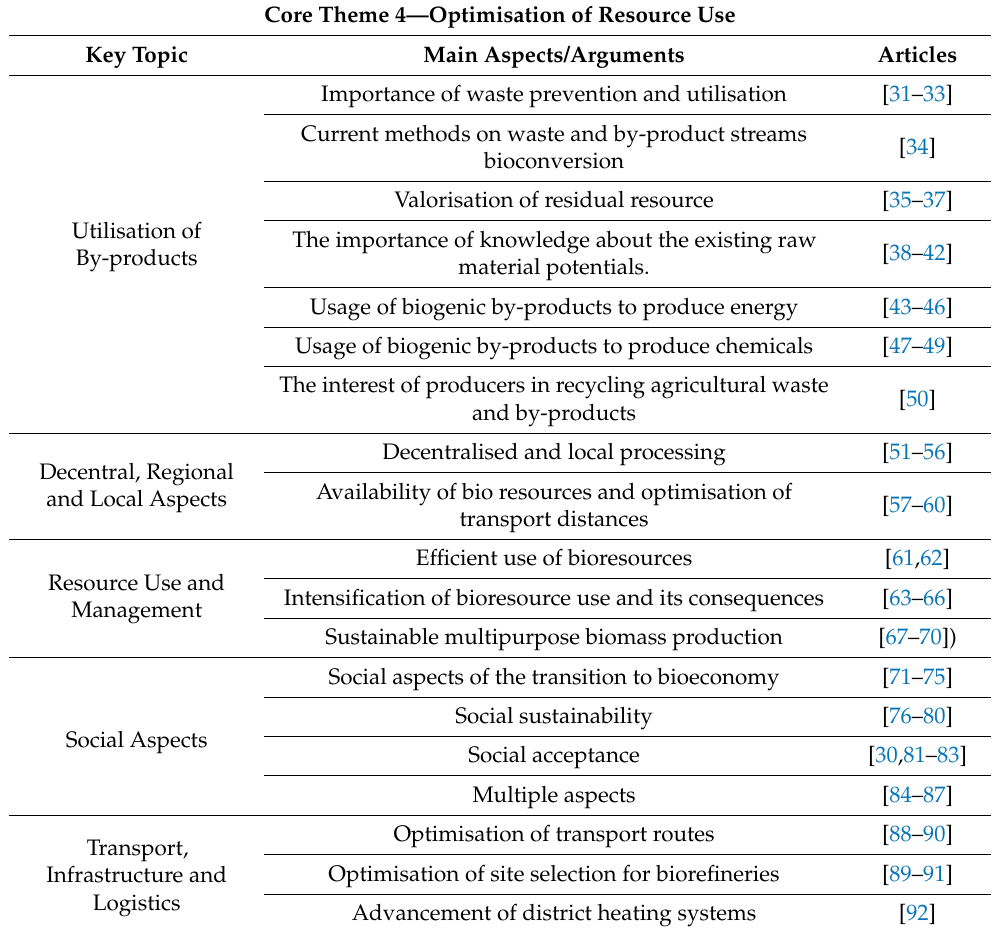
Table 4. Key topics and main aspects/arguments referring to Core Theme